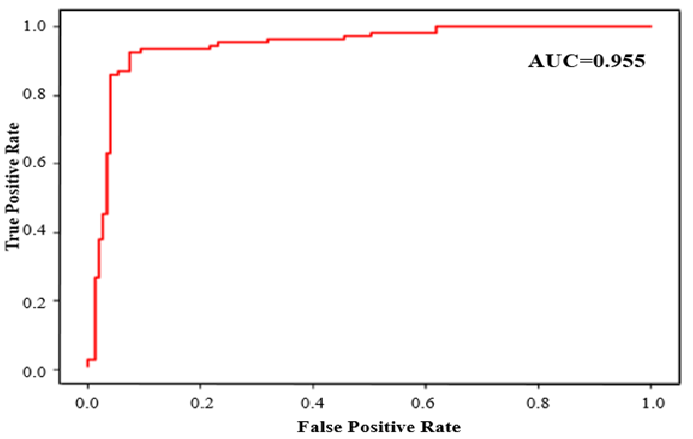
Figure 5. Result of AUC scores of capsule network .